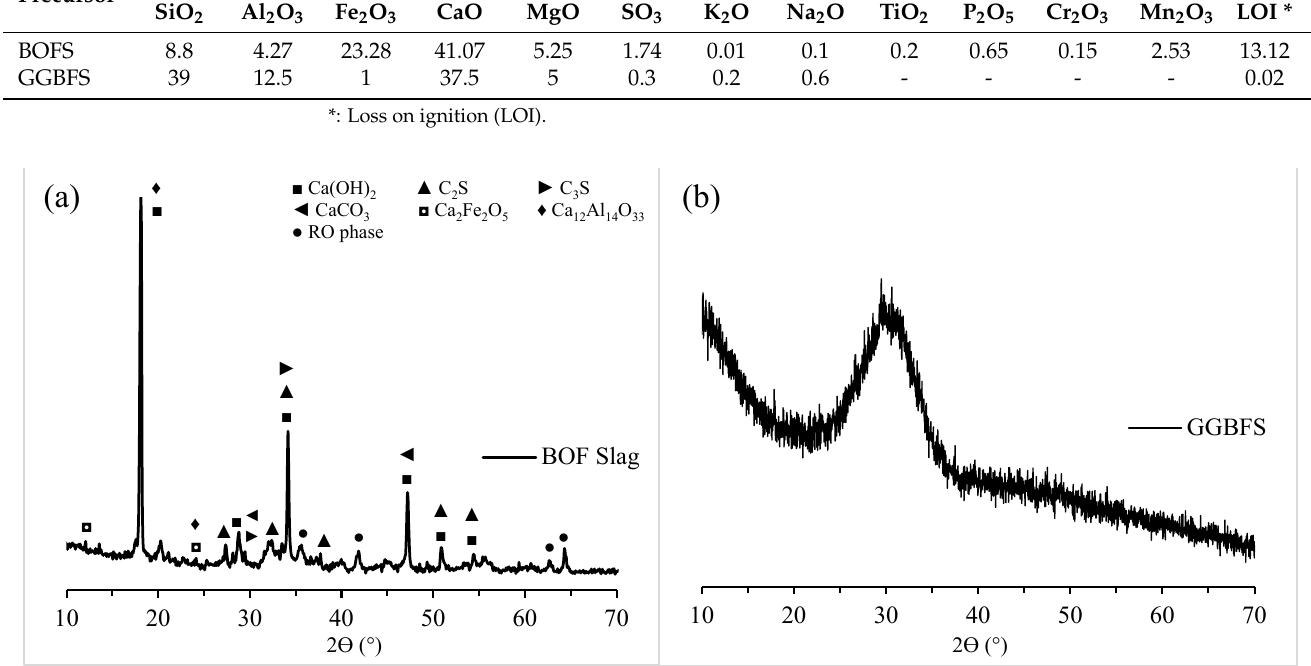
Figure 3. XRD of raw ( a ) BOFS and ( b ) GGBFS.